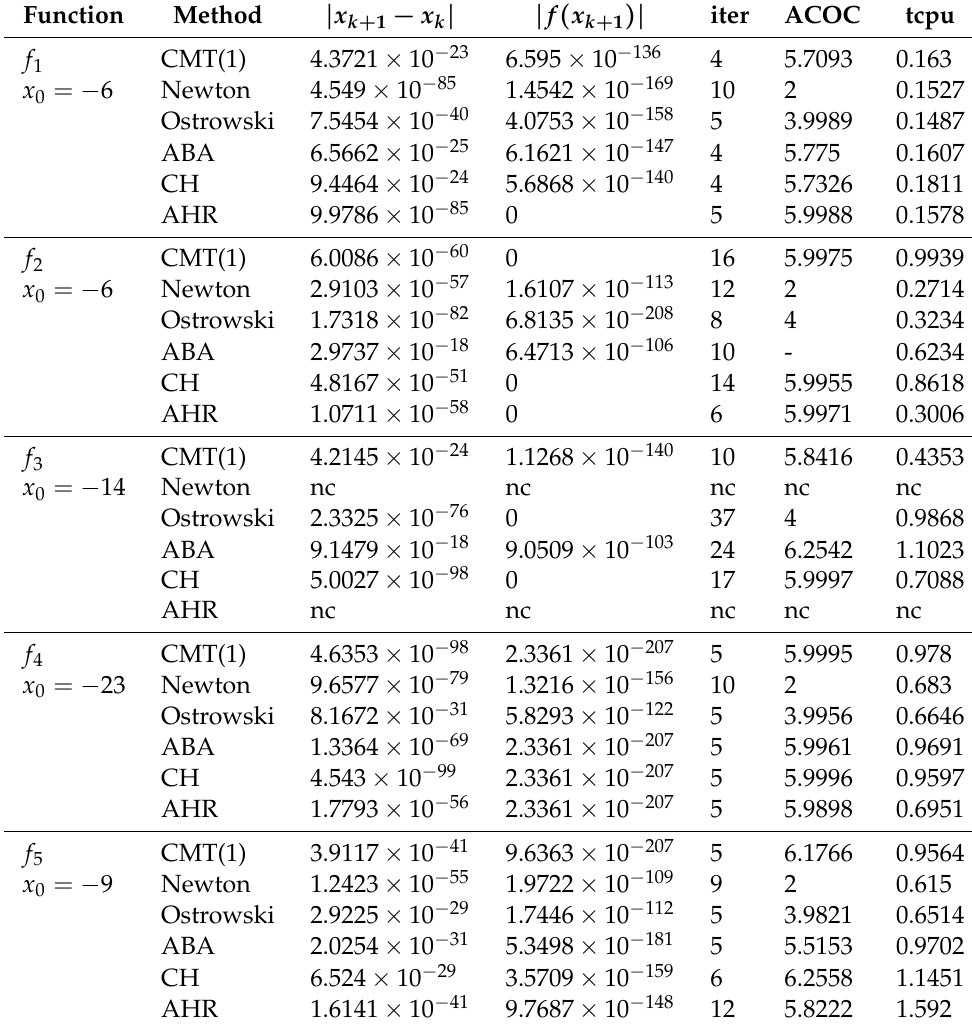
Table 2. Numerical performance of iterative methods in nonlinear equations for x 0 far from ξ